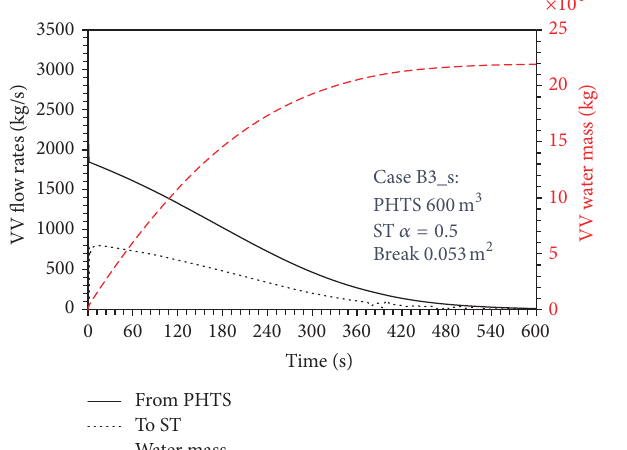
Figure 12: Break and relief flow rates and mass inventory in the VV (smaller break).